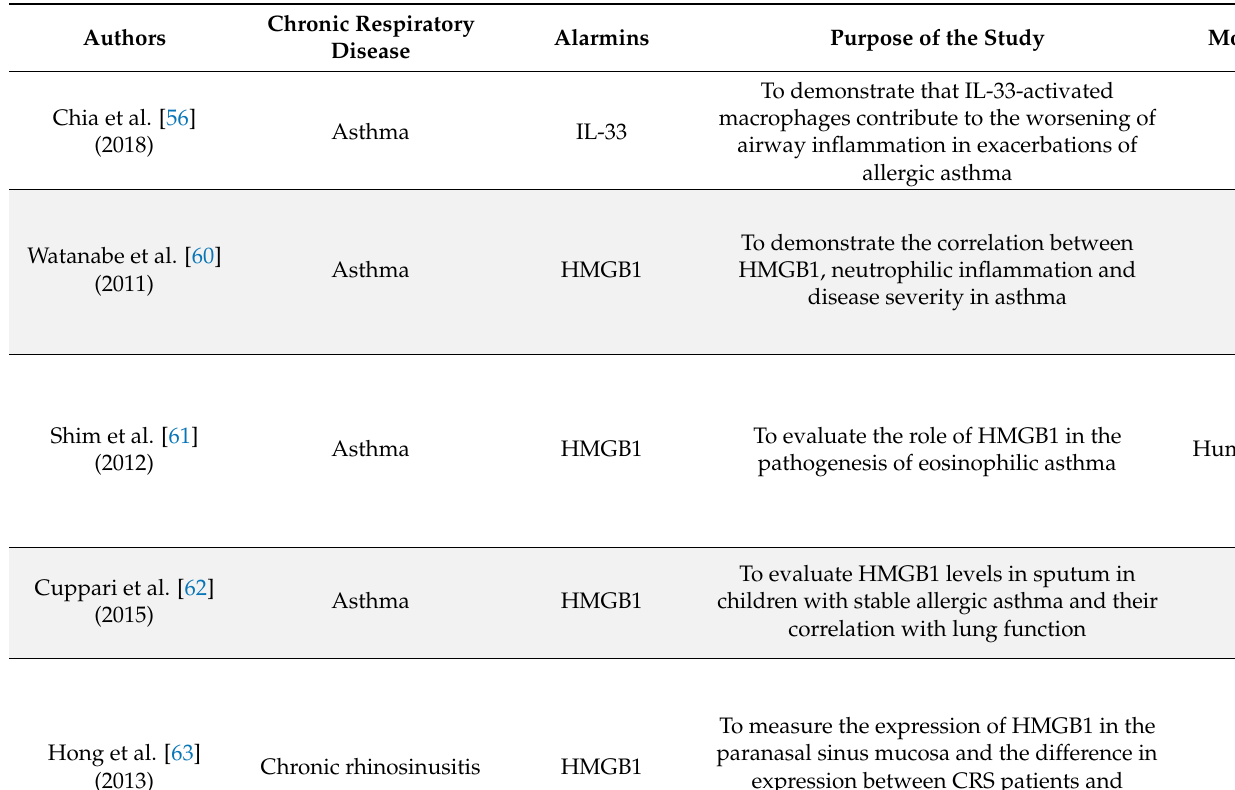
Table 1. Effects of alarmins on respiratory